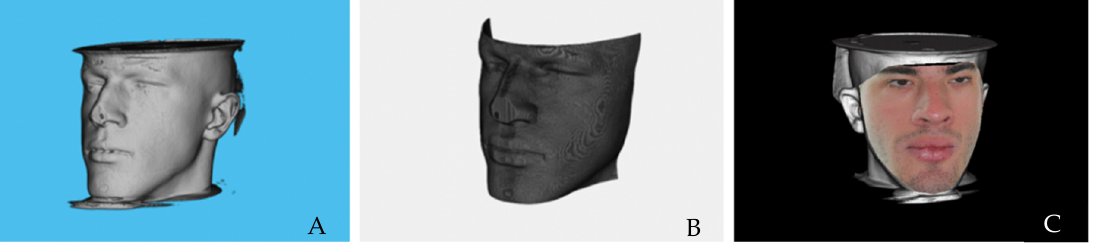
Figure 7. Combination of stereophotogrammetry images with CBCT images to create 3D virtual models of the patient: untextured soft tissue surface of the CBCT scan ( A , B ). Fusion of a CBCT soft tissue image with 3D stereophotographic images ( C ).